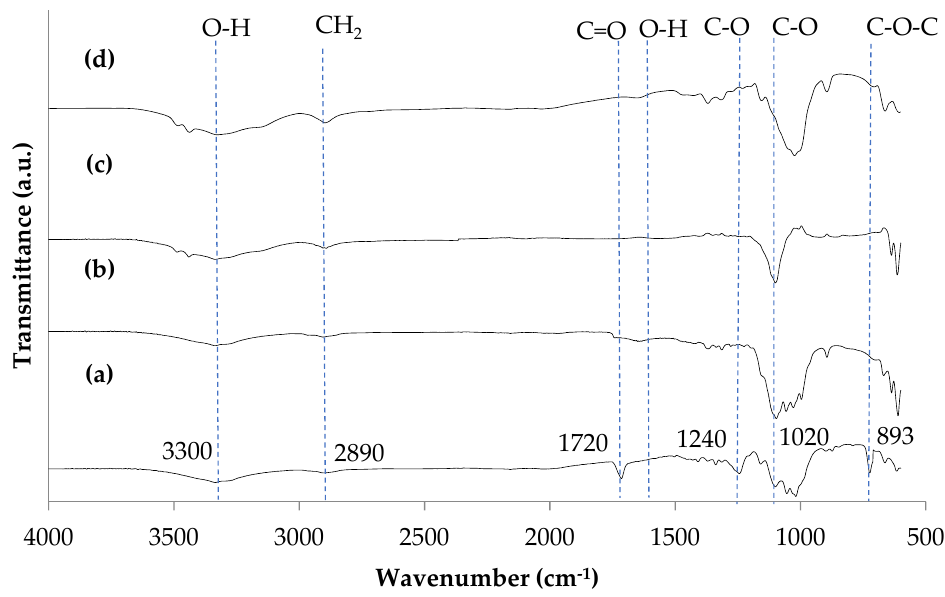
Figure 2. ATR-FTIR spectra of ( a ) waste cotton cloths, ( b ) scCO 2 pulped fiber, ( c ) CNCs isolated from waste cotton cloths, and ( d ) CNCs after Cr(VI) adsorption.